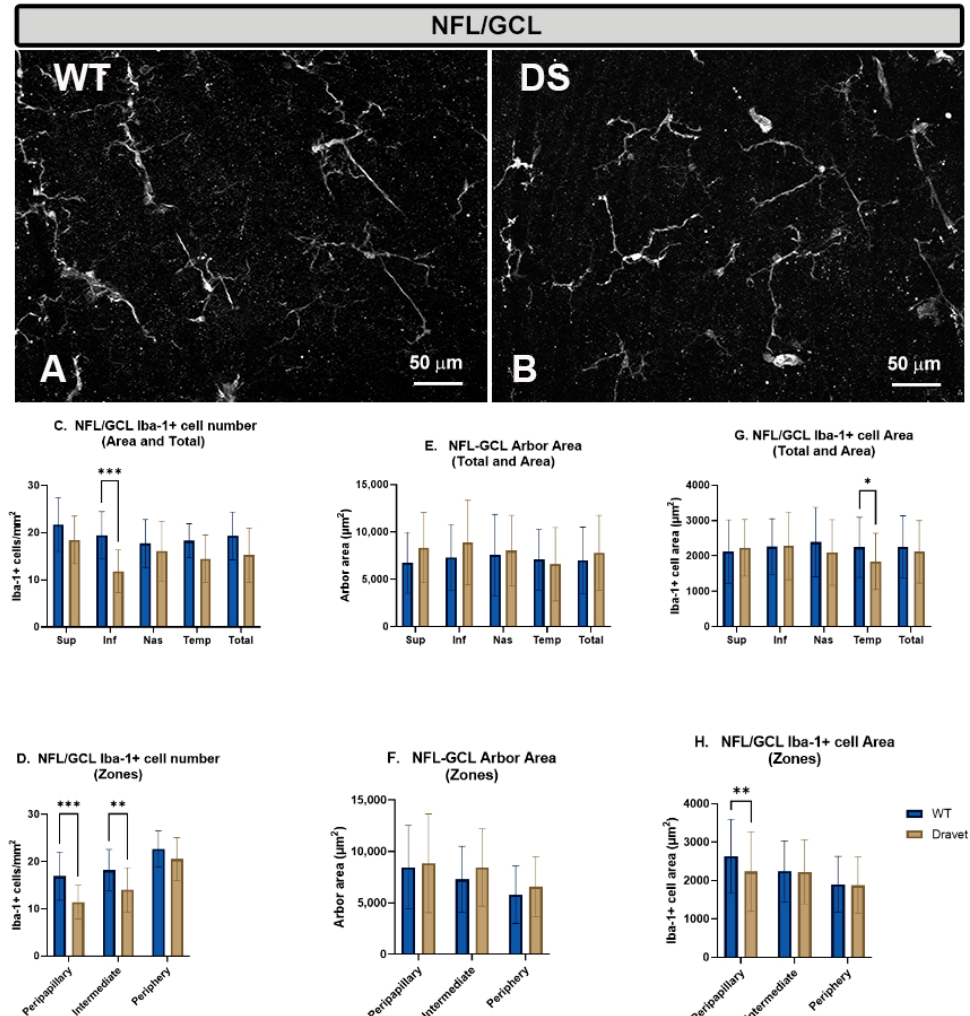
Figure 3. Microglial cells in the nerve fiber layer-ganglion cell layer (NFL-GCL). ( A , B ): retinal whole-mounts labeled with anti-Iba-1 at 20 × magnification. No major changes were observed between the Dravet syndrome (DS) and the WT animals. ( C , D ): number of Iba-1+ microglial cells per retinal area 0.1502 mm 2 by total retina and area ( C ) and by zone ( D ). ( E , F ): Arbor area of Iba-1+ microglia by total retina and area ( E ) and by zone ( F ). ( G , H ): Iba-1+ cell area by total retina and area ( G ) and by zone ( H ). Two-way ANOVA. Data expressed as mean value ( ± SD). * p < 0.05, ** p < 0.01, *** p < 0.001. Number of retinas used in the experiment: WT animals n = 6, DS animals n = 6. Sup: superior; Inf: inferior; Nas: nasal; Temp: